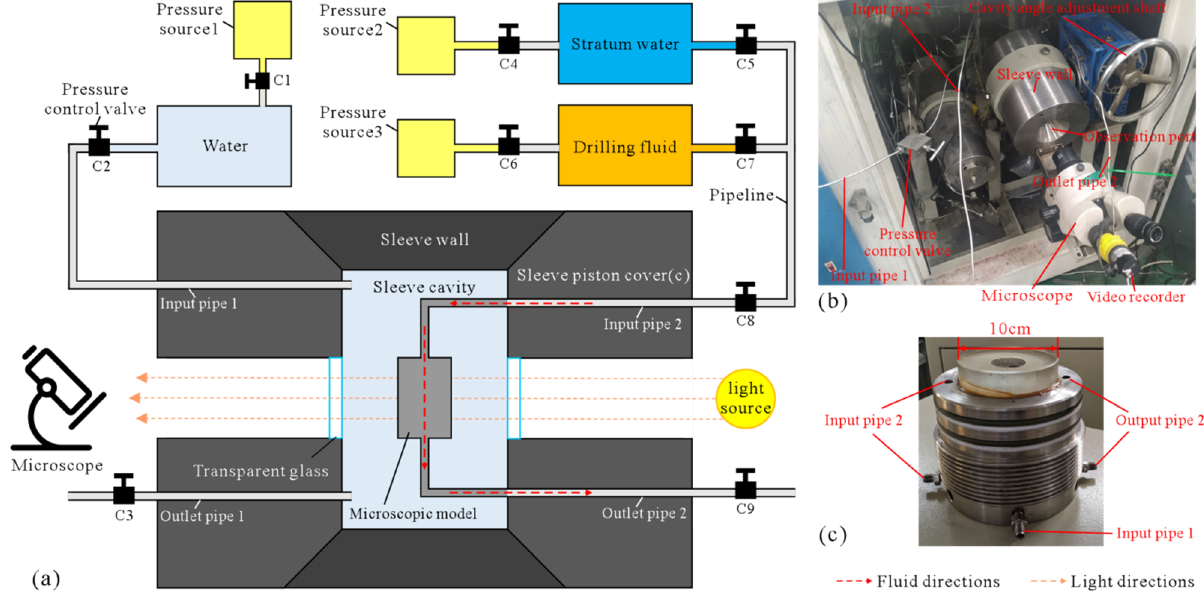
Figure 3. Experimental device: ( a ) schematic diagram of the cross section of the microdisplacement experimental device; ( b ) image of the experimental device assembly; ( c ) stainless steel sleeve cavity.